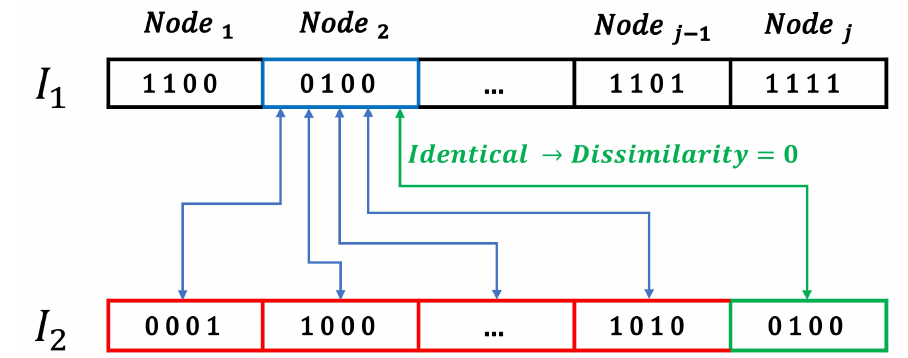
) with each node of the 2 and I 2 N is zero since they are identical and is j 2